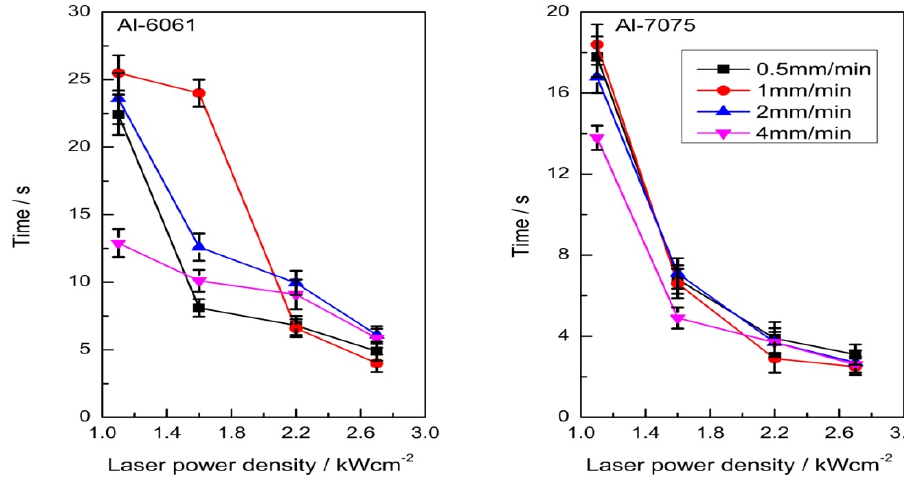
Figure 3. Failure time of Al-6061 and Al-7075 type specimens against laser power density, under different preloaded speeds.